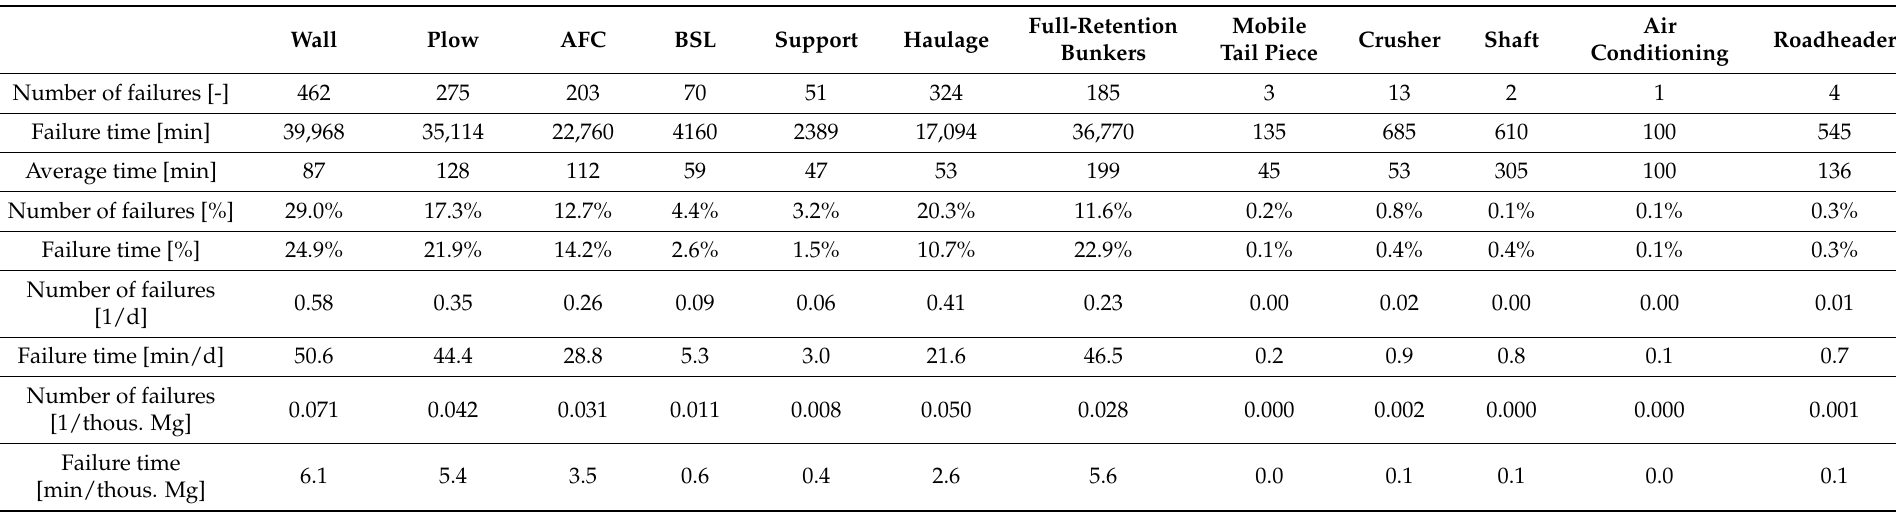
Table 5. Summary of information on the time and number of failures in plow